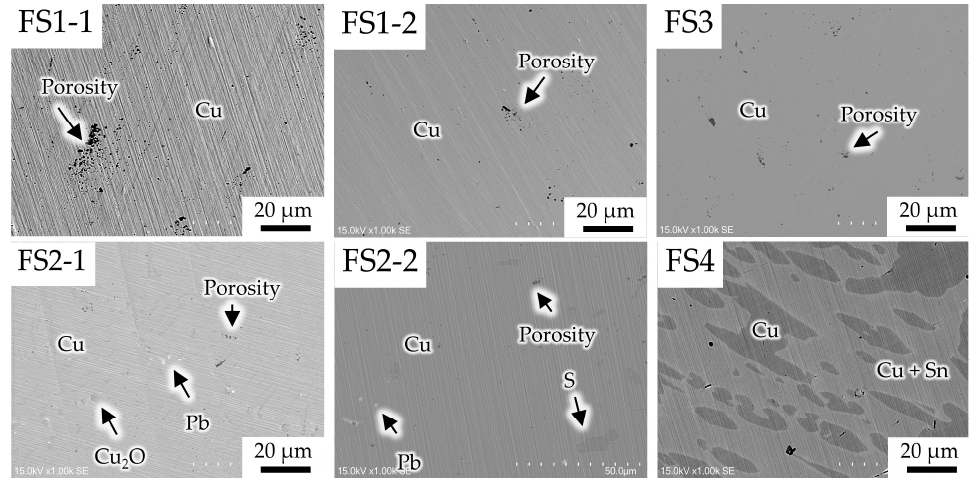
Figure 5. Microstructural compositions of the molten marks.